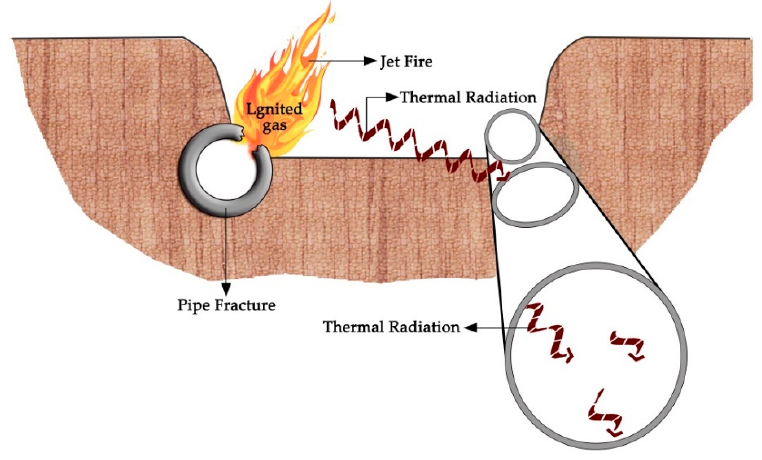
Figure 11. Failure of the adjacent pipeline caused by thermal radiation.